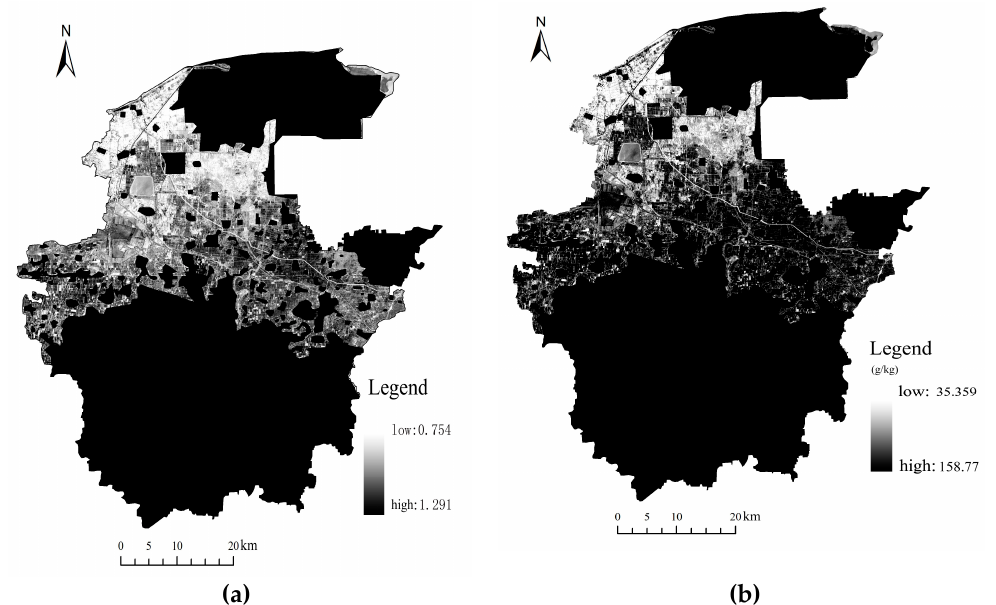
Figure 4. SDI and Retrieval of Soil Salt Content from PMS Images in Northern Shouguang in 2017. ( a ) SDI; ( b ) SALT.